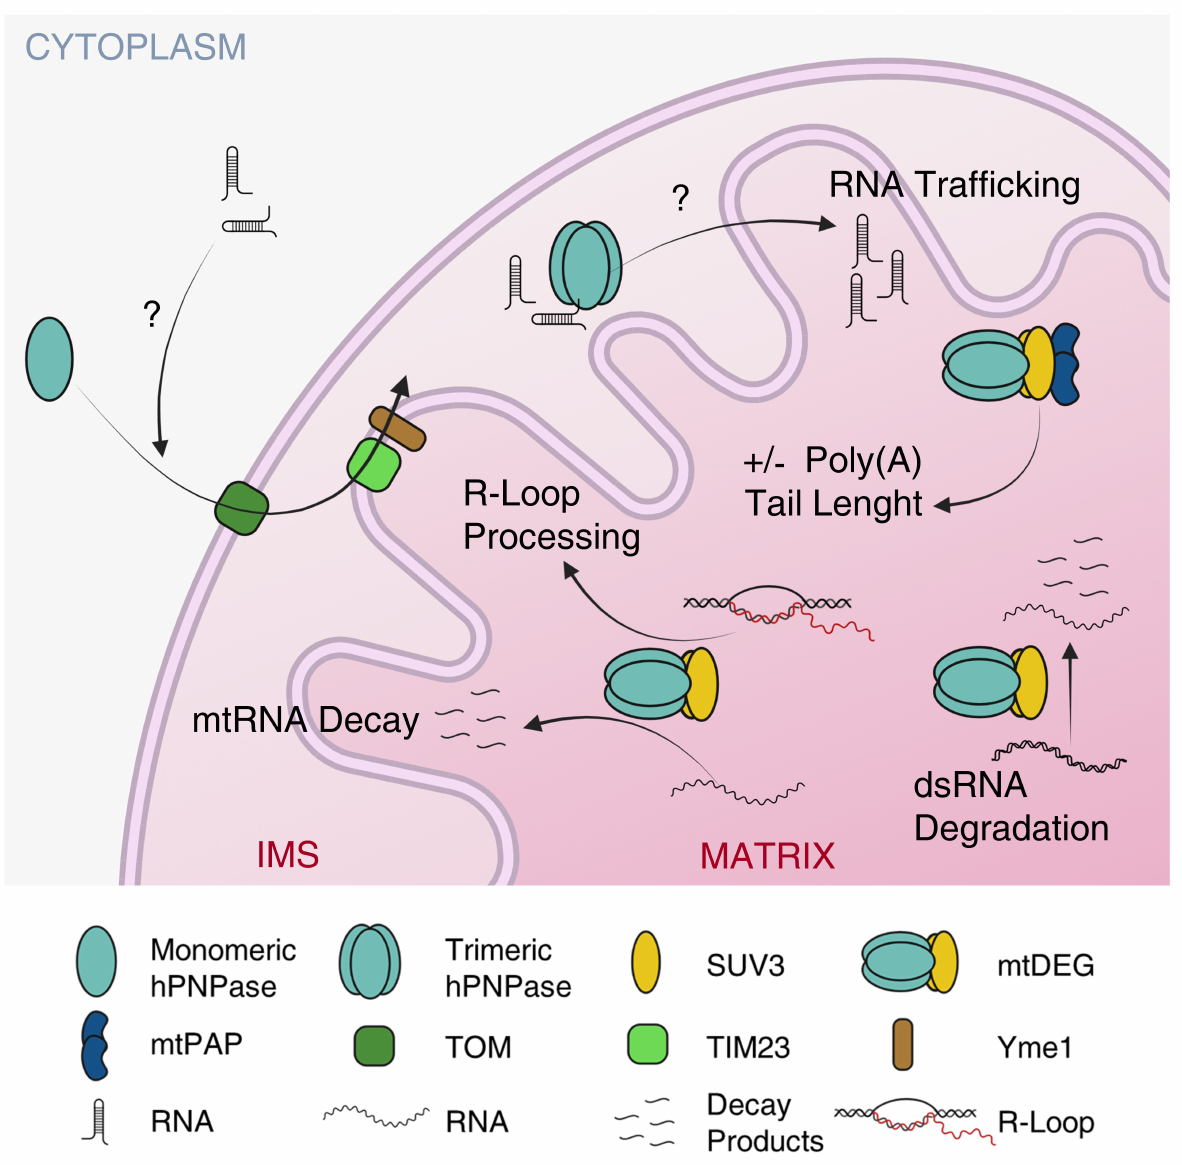
Figure 3. hPNPase mitochondrial functions. RNA to be imported may cross the mt outer membrane through the TOM translocon. hPNPase in the IMS facilitates RNA transport to the matrix with an unclear mechanism. In the matrix, the mtDEG regulates the decay and the polyadenylation of mtRNA, the degradation of dsRNA, and the processing of R-loops. Created with Biorender.com. Available online: https://biorender.com/ (accessed on 27 January